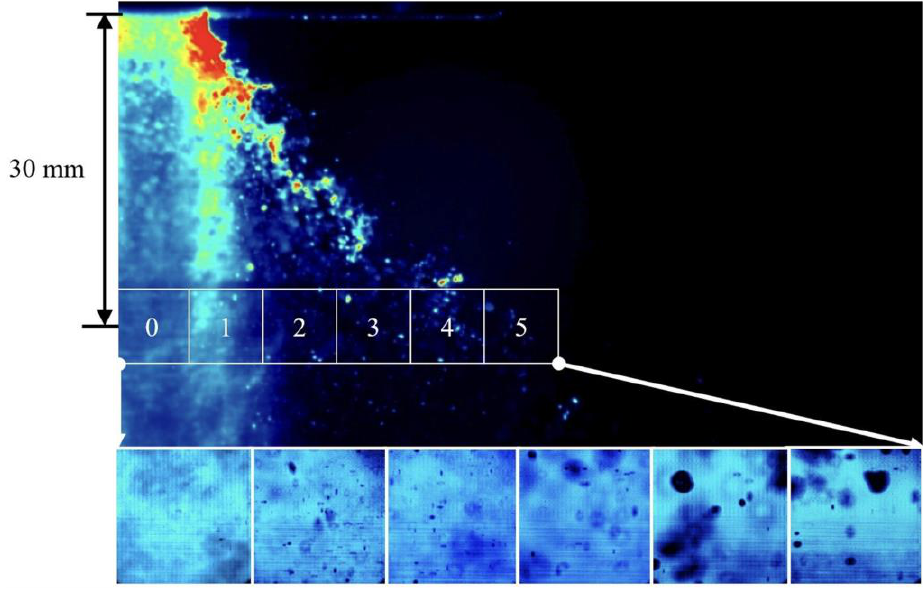
Figure 7. SMD measurement zone.